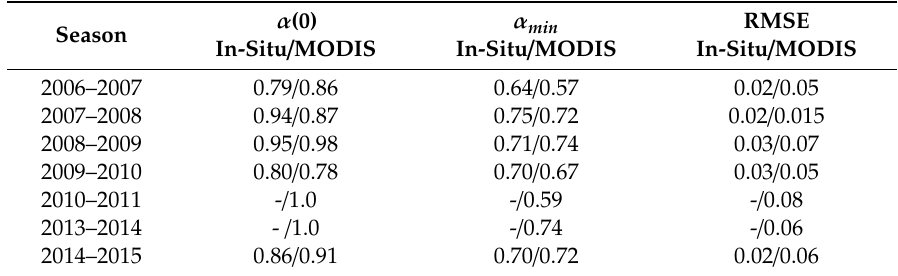
Table 8. Values of the initial ( α (0)) and minimum ( α min ) values of albedo during the albedo decay for each season, for in-situ and MOD10A1 albedo data. The Root Mean Square Error (RMSE) is also given. α Season